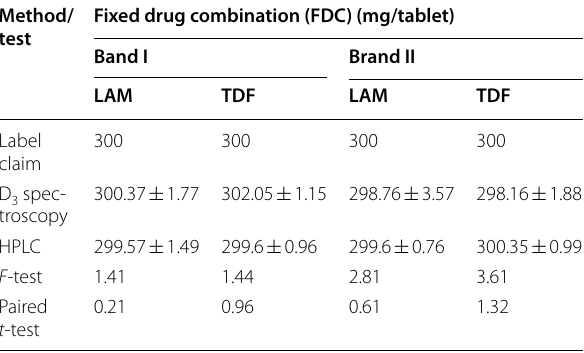
Theoretical values for t -distribution and F -distribution (at 4 degree of freedom) are 2.776 and 6.39, respectively